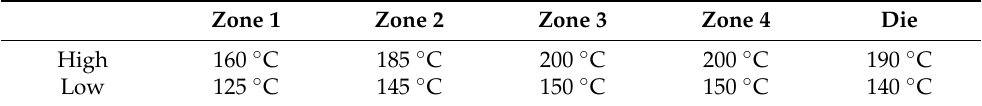
Table 3. Temperatures of extrusion